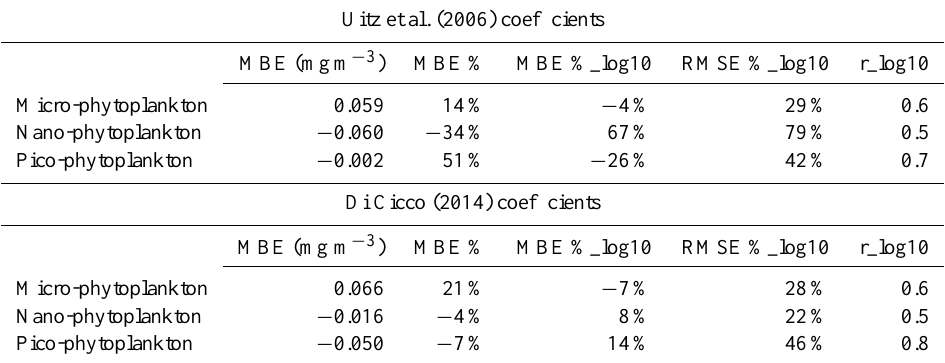
Table 2. Statistical results from the comparison of the BR model and in situ PSC classification obtained using, in the diagnostic pigments analysis, respectively the Uitz et al. (2006) and the Di Cicco (2014) coefficients. Mean bias error (MBE) has the same dimensions of in situ observations ( x in Table 3), while mean bias error percentages (MBE %), root mean square error percentages (RMSE %) and linear Pearson correlation coefficients ( r) are dimensionless and refer to a TChl a smoothed with a 5-point running mean. Where “_log10” refers to log-transformed units, otherwise it is expressed in linear space.